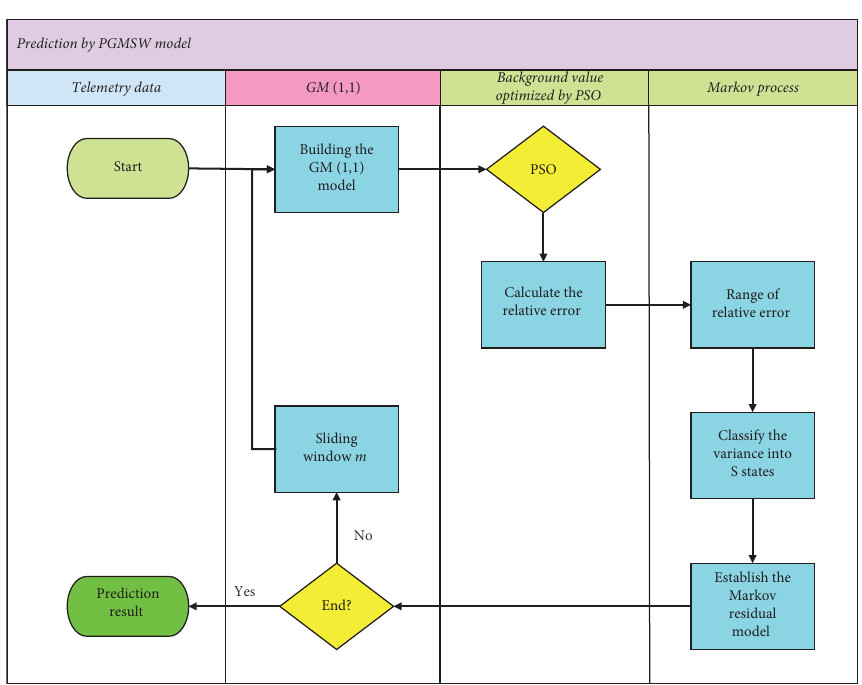
Figure 2: Flow chart of prediction by PGMSW model.